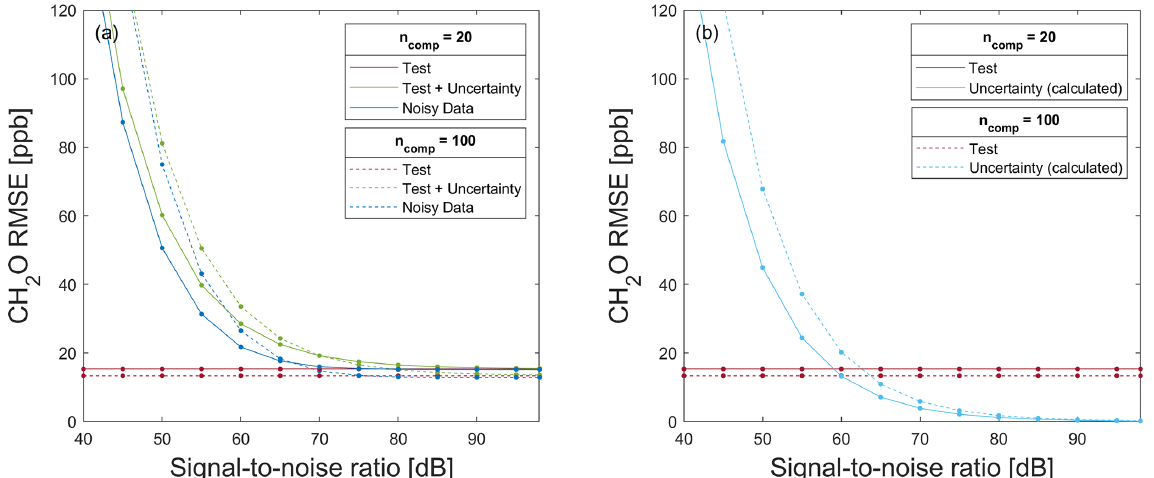
Figure 10. RMSE for testing a model trained with 80% raw data for formaldehyde prediction on (a) 20% test data without (red) and with associated uncertainty values (green), in addition to the application of the model on a noisy data set (blue) and (b) 20% raw test data (red), and the calculated uncertainty RMSE (light blue) resulting from the difference in T + U − RMSE and T − RMSE for a different number of PLSR